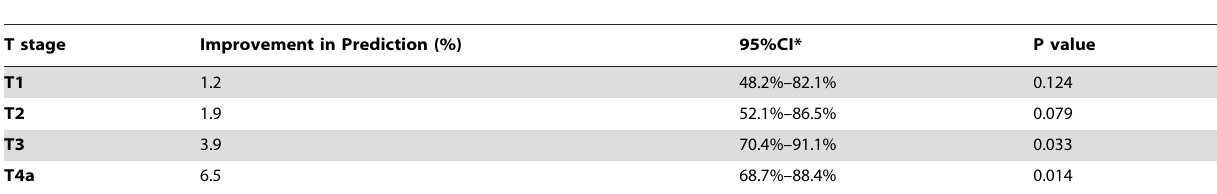
Table 4. Effects of T stage and tumor size on the accuracy of prognostic predictions in patients with gastric cancer.